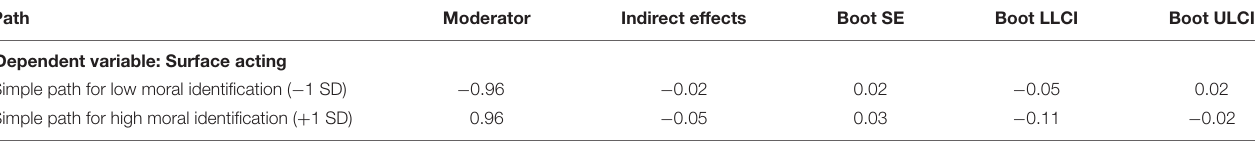
TABLE 3B | Conditional indirect effects of CSR perception on deep acting at values of moral identification.